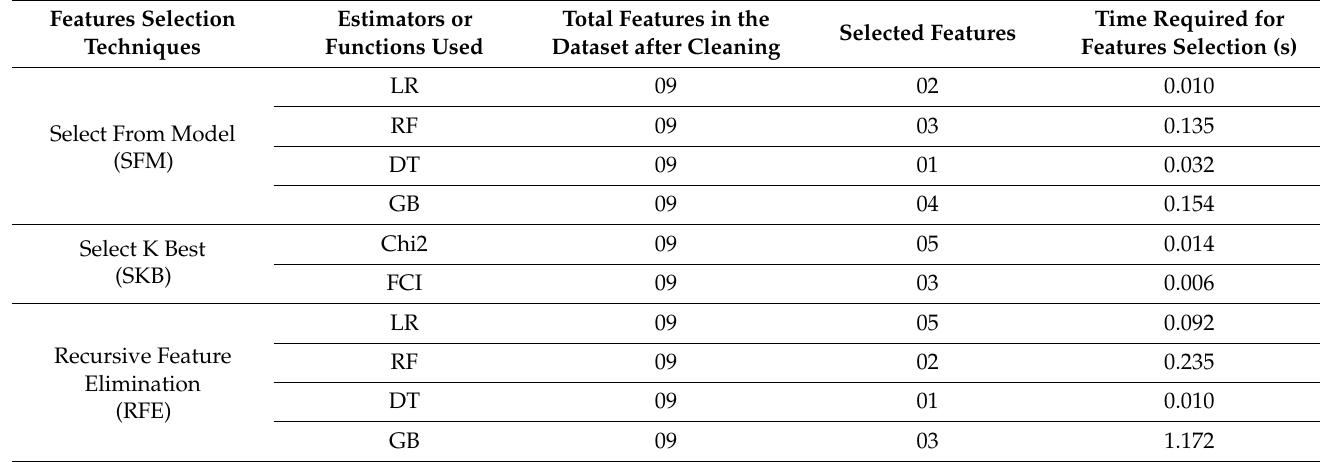
Table 2. Details of the attributes selected by the feature-selection approach with the execution